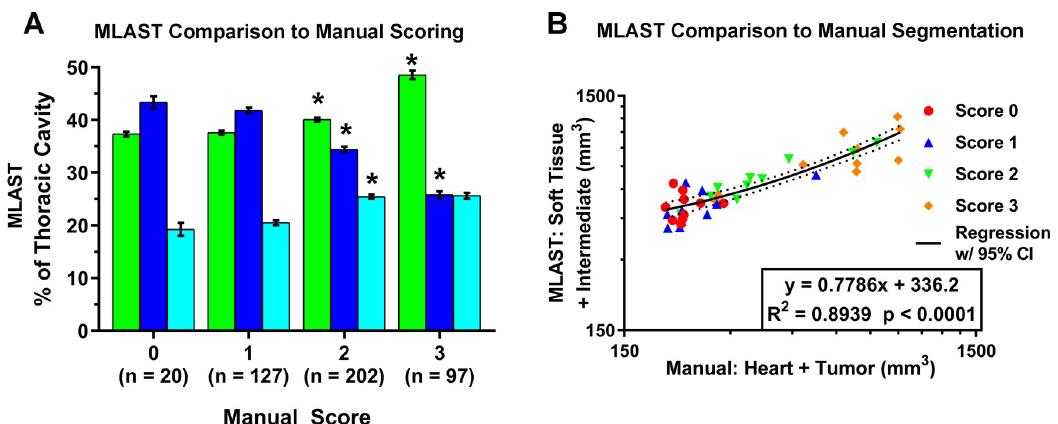
Fig 4. Comparison of MLAST with manual scoring system and manual segmentation. (A) Results comparing MLAST values (% thoracic cavity) to manual scores on a 0–3 scale. MLAST values represent soft tissue (green bar), lung (blue bar) and intermediate density (cyan bar). The number of samples that corresponded to manual scores 0–3 is represented in Y-axis. Error bars are standard error of mean and � indicates statistical significance by Student’s t-test at a Bonferroni-corrected significance level of α = 0.0056. (B) Comparison of the three methods: manual scored samples, manually segmented volume and MLAST values. Linear regression analysis of automatically segmented thoracic tissue (intermediate + soft tissue) by MLAST vs manually segmented thoracic soft tissue (heart + tumor) volume on a log scale show good